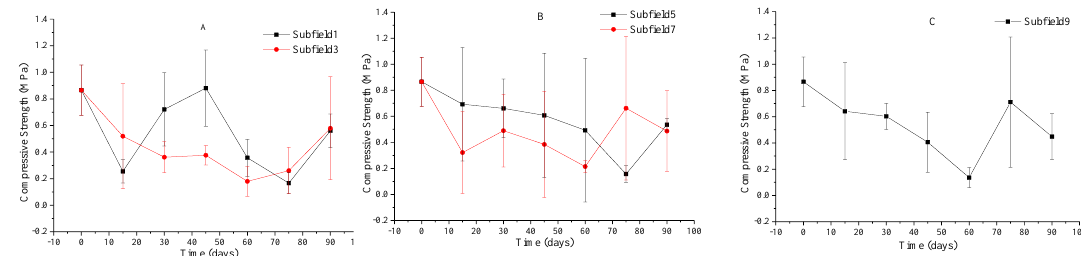
Figure 10. Changes in the compressive strength over time with different tillages. Note: ( A )—Plowing; ( B )—Dry rotary; ( C )—Wet Rotary.